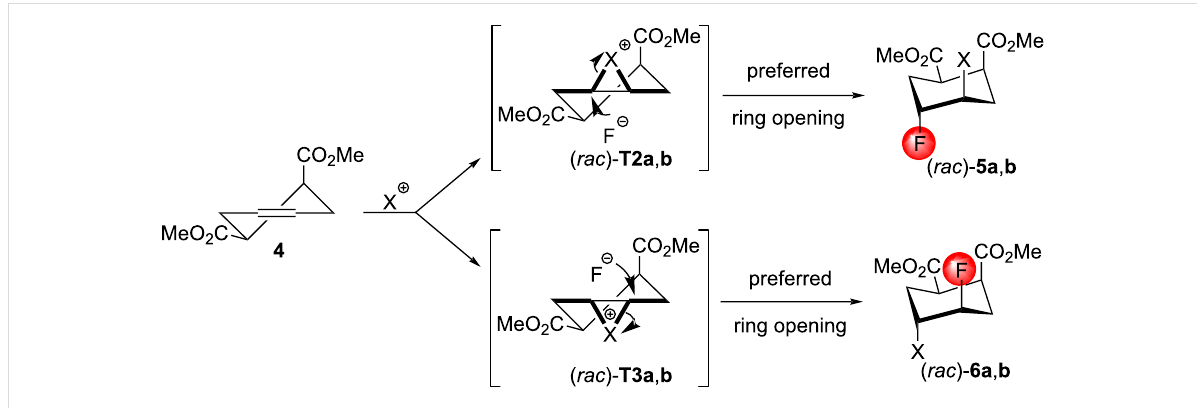
Scheme 3: Probable outcomes of the halofluorination of 4 . Both conformers of the compounds 4 , ( rac ) - T2a , b , and ( rac ) - T3a , b , respectively, have an equal energy. ( rac ) - 5a and ( rac ) - 6a : X = Br; ( rac ) - 5b and ( rac ) - 6b : X = I.